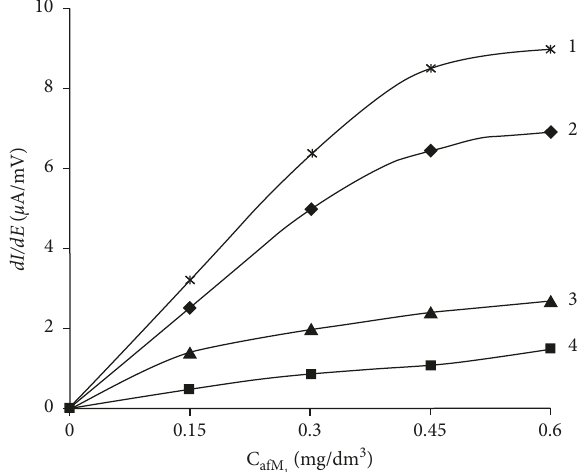
Figure 2: Calibration dependences of electric oxidation of afla- toxins N 1 (1 and 3) and C 1 (2 and 4) on various background electrolytes: (1, 2) 0.1 N S 6 O 5 P 7 (NH 4 ) 3 ; (3, 4) 0.1 N (NH 4 ) 2 SO 4 .